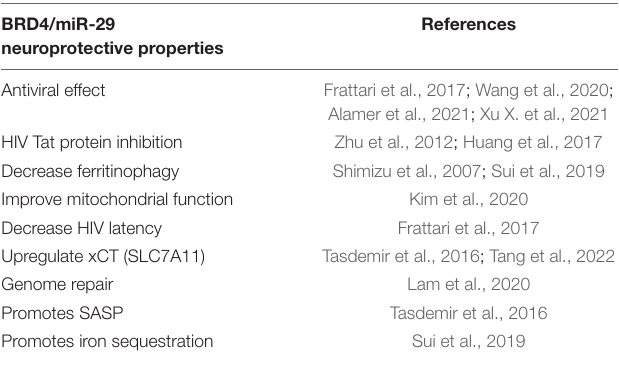
TABLE 1 | Anti-FIN properties of